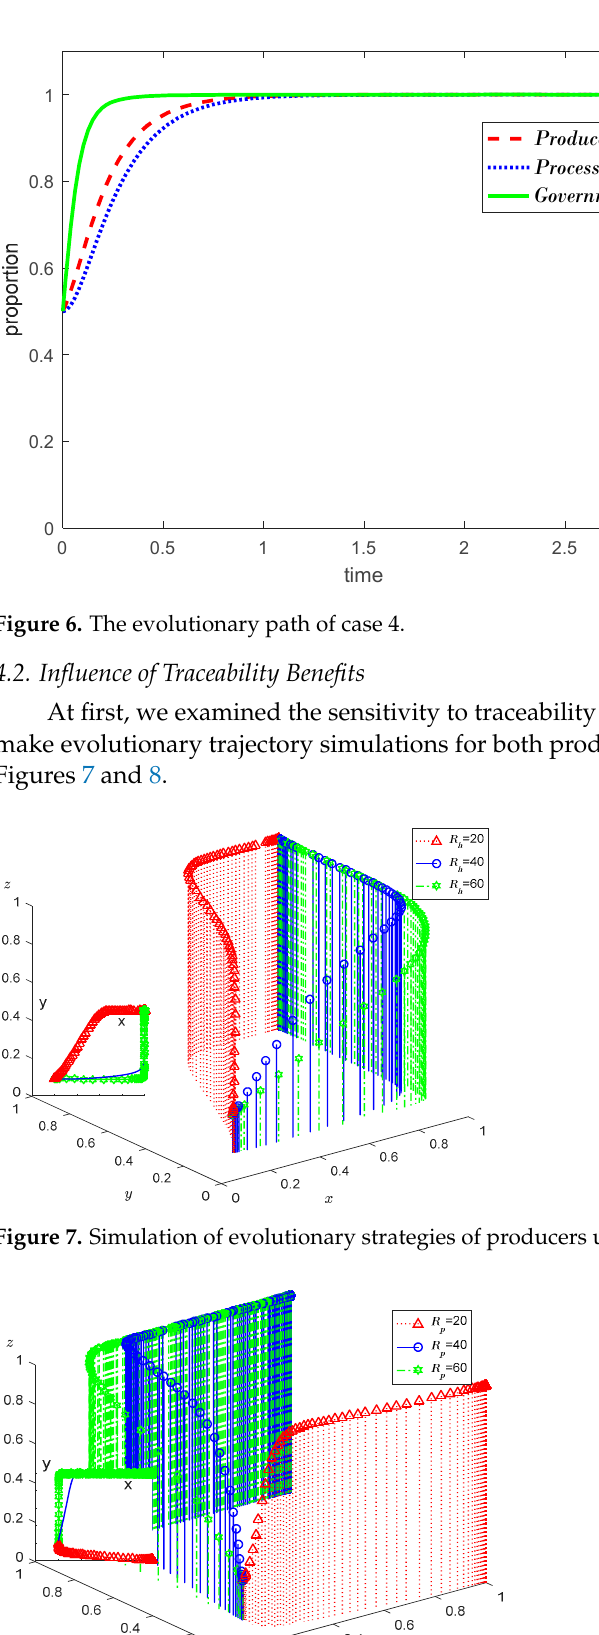
Figure 8. Simulation of evolutionary strategies of processors under different traceability benefits.